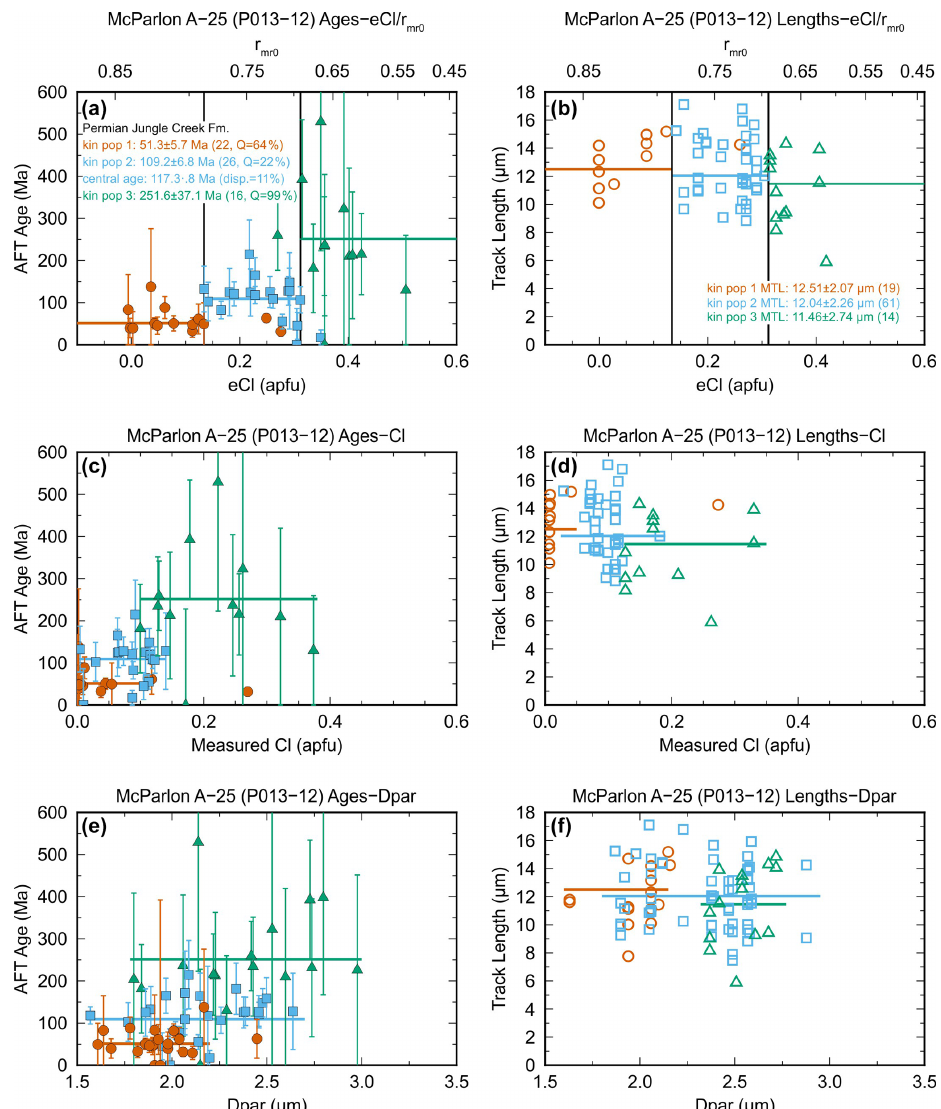
Figure 4. Plots of (a) single-grain ages and (b) track lengths grouped into different colour-coded kinetic populations using eCl values for the Permian well sample. Boundary between populations is indicated by vertical black lines. Similar plots of population ages and lengths with respect to Cl concentration (c, d ) and D par (e, f) using the same colour coding as in (a) and (b) are also